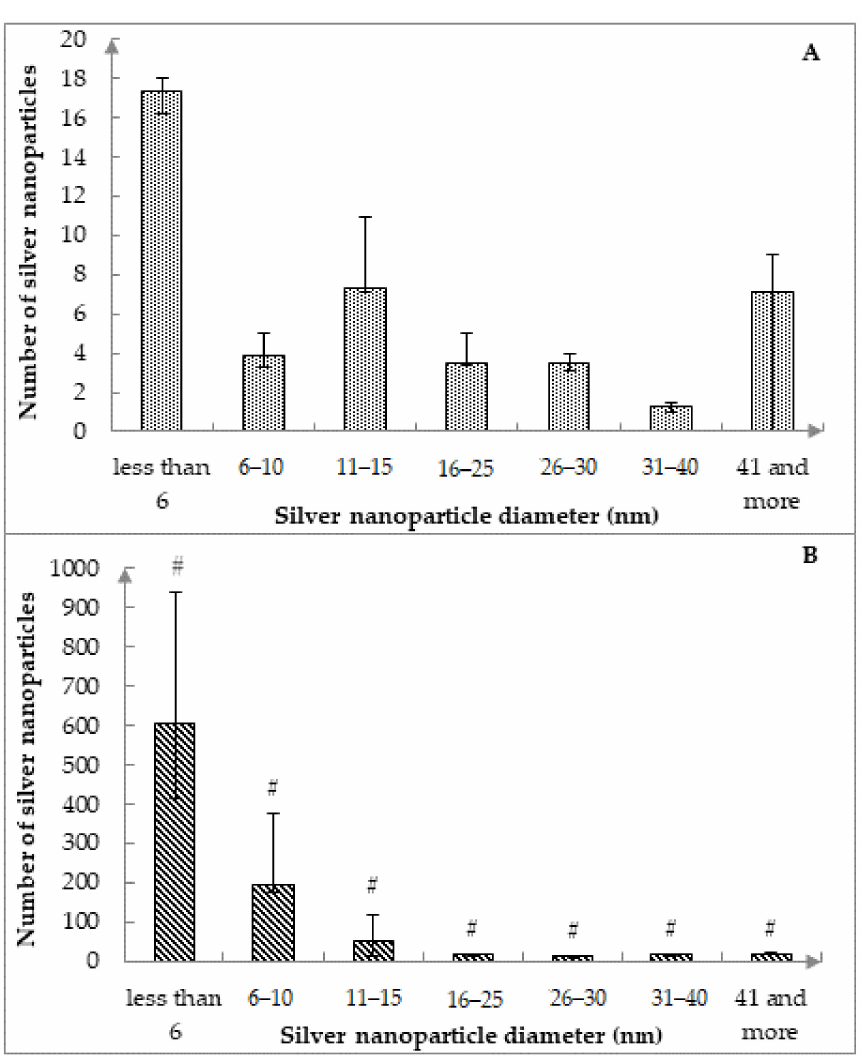
Figure 5. Distribution of silver nanoparticles on the surface of perlon suture material without exposure to temperatures below 0.0 ◦ C ( A ) and after 10-fold cyclic freezing ( B ). Note: #— p < 0.05, compared to the same size range before cyclic freezing; data are presented as Me, P 25 , P 75